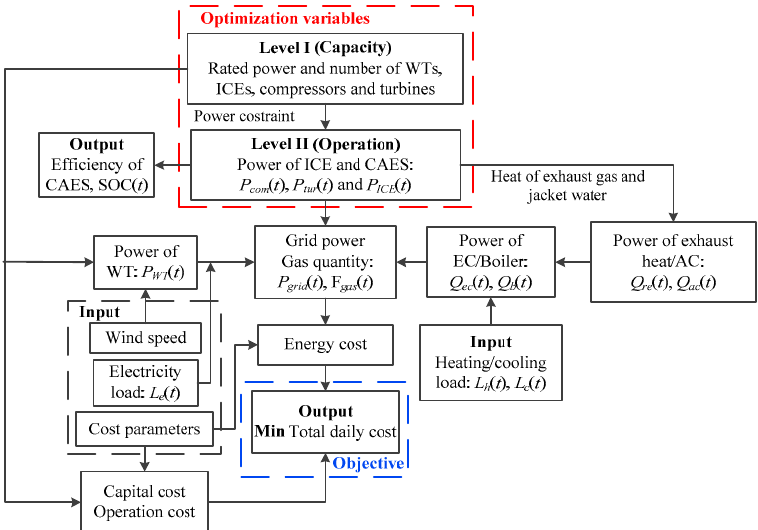
Figure 2. Calculation strategy of the HES with CAES.